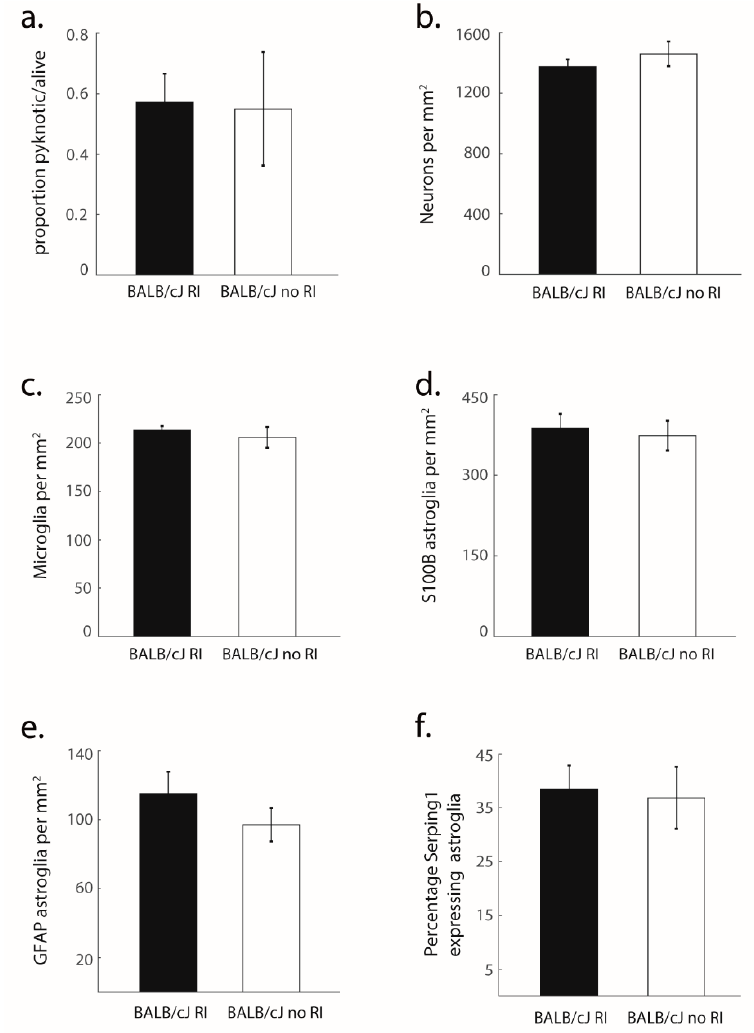
Figure 3. Histological measures in BALB/cJ animals with and without RI test: ( a ) Proportion pyknotic neurons/healthy neurons in MCC of BALB/cJ mice that participated in the RI ( N = 9) test versus those that did not ( N = 6). Shown are average and SEM; ( b ) Same as a for neuron density per mm 2 ; ( c ) Same as a for microglia per mm 2 ; ( d ) Same as a for S100B positive astroglia per mm 2 ; ( e ) Same as a for GFAP positive astroglia per mm 2 ; ( f ) Same as a for percentage toxic astroglia. None of the comparisons are significant.